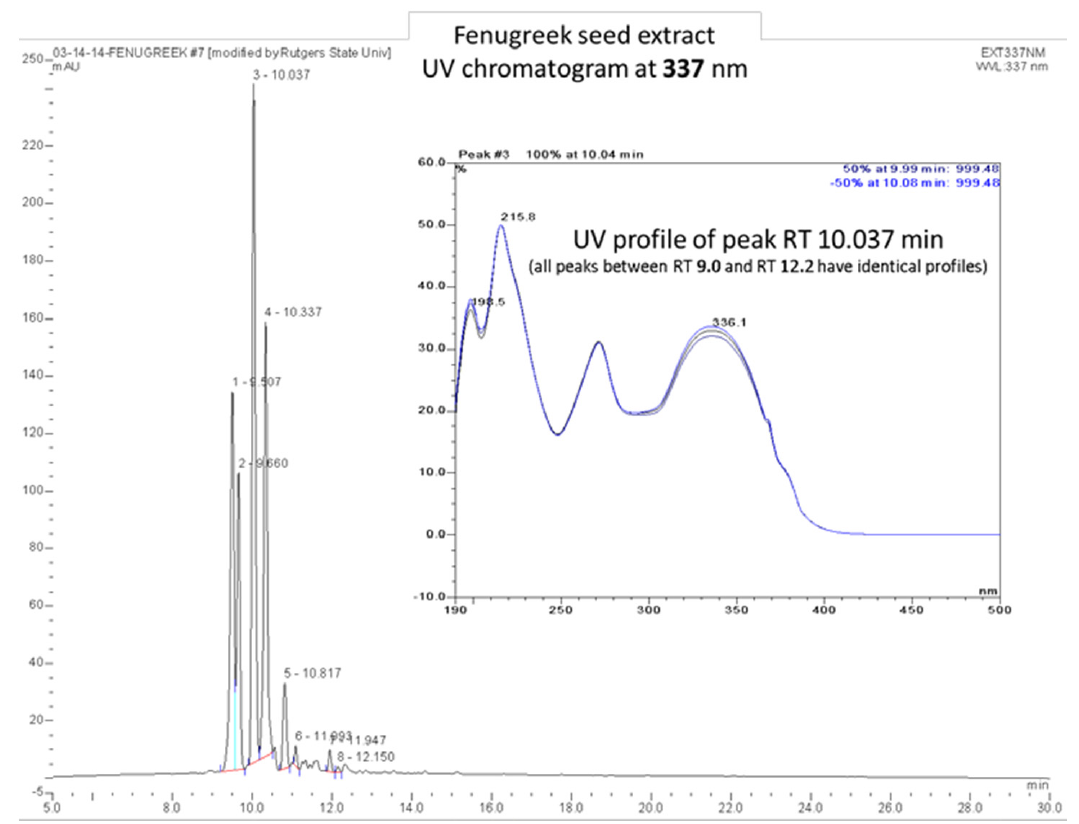
Figure A1. UV Chromatogram fingerprint of fenugreek seed extract at 337 nm. The fingerprint shown in Figure A1 is characterized by a series of peaks between RT 8 min and RT 12.5 min which appear to be polyphenols, mainly flavonoid di- and trisaccharides, based on their corresponding masses*, MS profiles, and UV profiles. The inserted UV spectrum is identical for all peaks suggesting similar phytochemical identity.